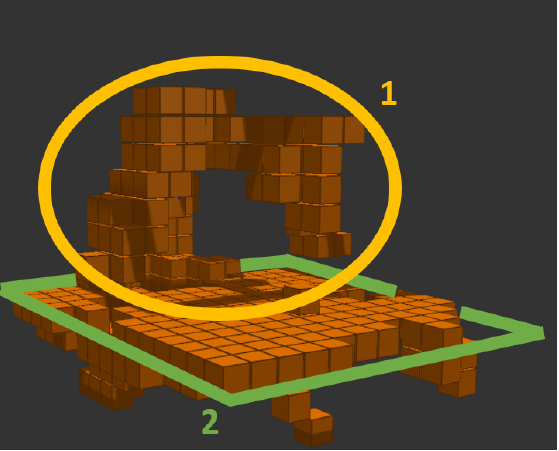
Figure 5. Cropping voxel map to workspace: 1. robot; 2. robot workspace boundaries.